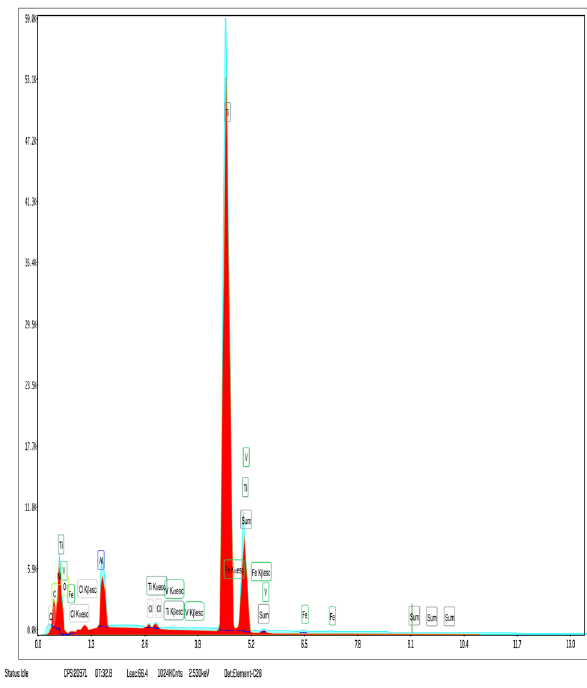
Figure 13: EDS of sample S4.